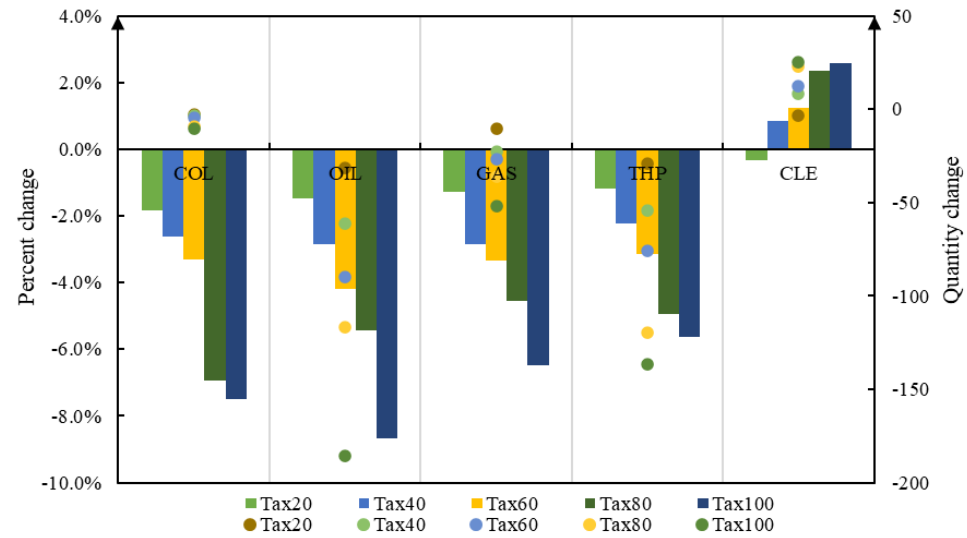
Figure 6. The relative and absolute impact on energy demand.